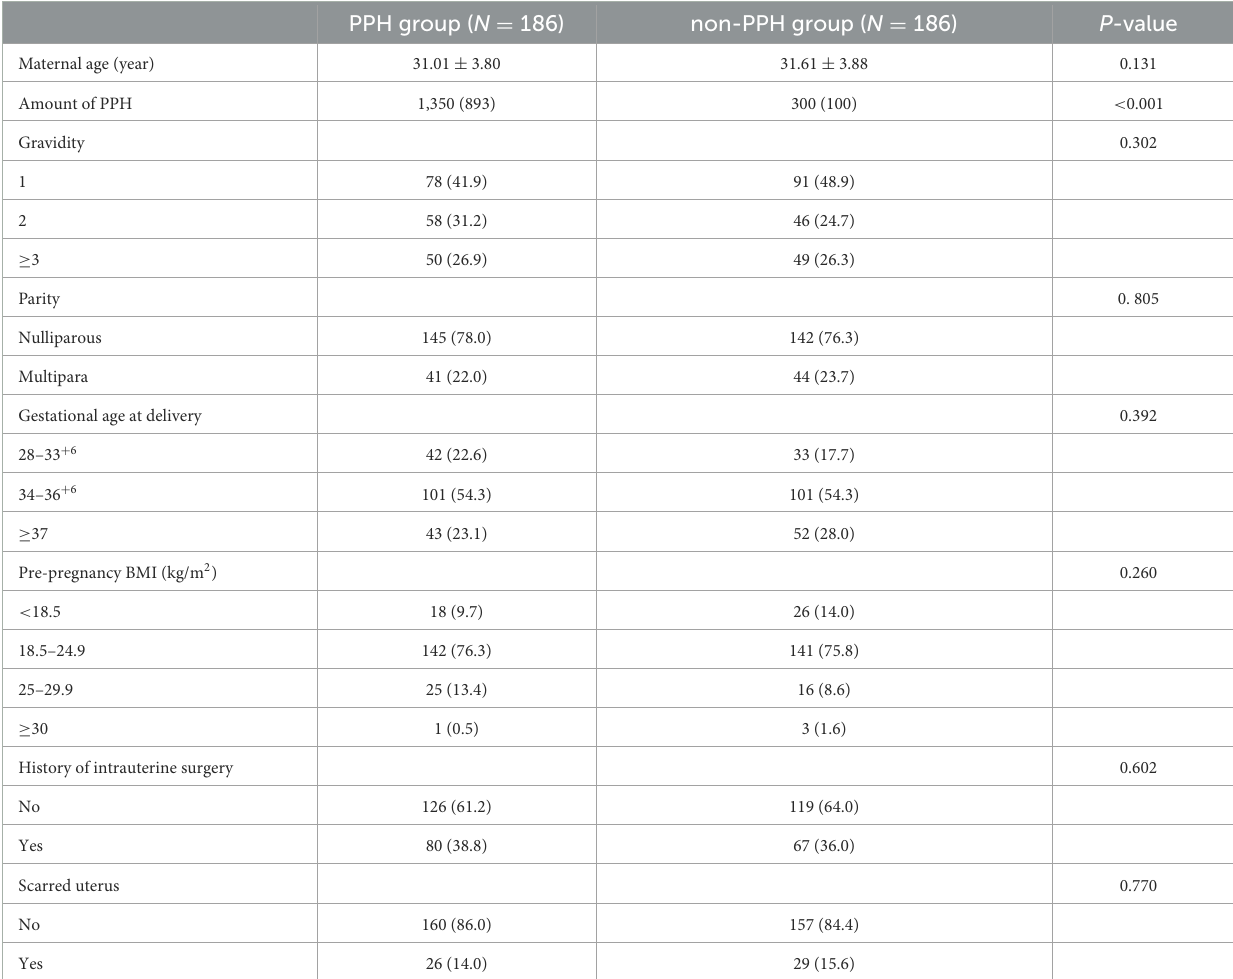
TABLE 1 Baseline characteristics of propensity score-matched PPH study cohort with and non-PPH control